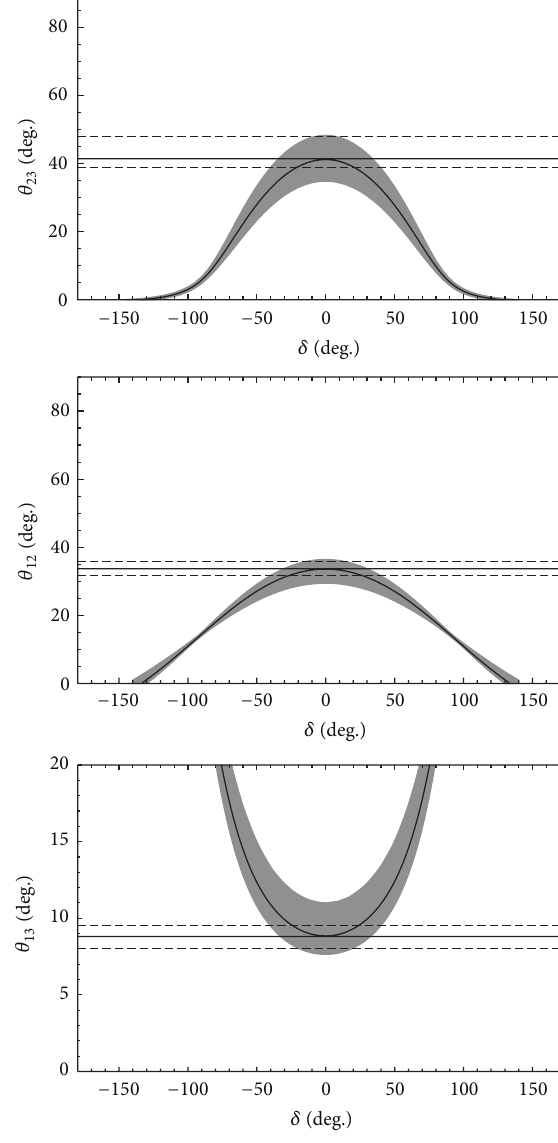
Figure 1: The 2 𝜎 allowed regions (shaded bands) in the ( 𝛿 , 𝜃 13 ), ( 𝛿 , 𝛿 , 𝜃 𝜃 12 ), and ( 23 ) planes using measurements (with uncertainties) of the other two neutrino mixing angles and the CKM parameters. The solid curves within the shaded bands are the model predictions for the best-fit values of the other two mixing angles and the CKM parameters. The horizontal solid lines mark the best-fit values and the horizontal dashed lines mark the 2 𝜎 limits of 𝜃 23 , 𝜃 12 , and 𝜃 13